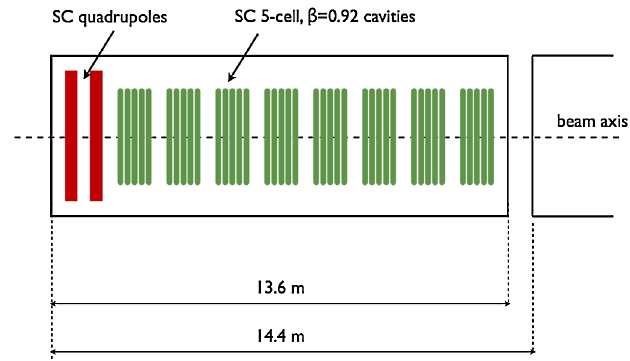
FIG. 3. (Color) SPL cavity/cryomodule layout in the high- energy section (five-cell, 704.4